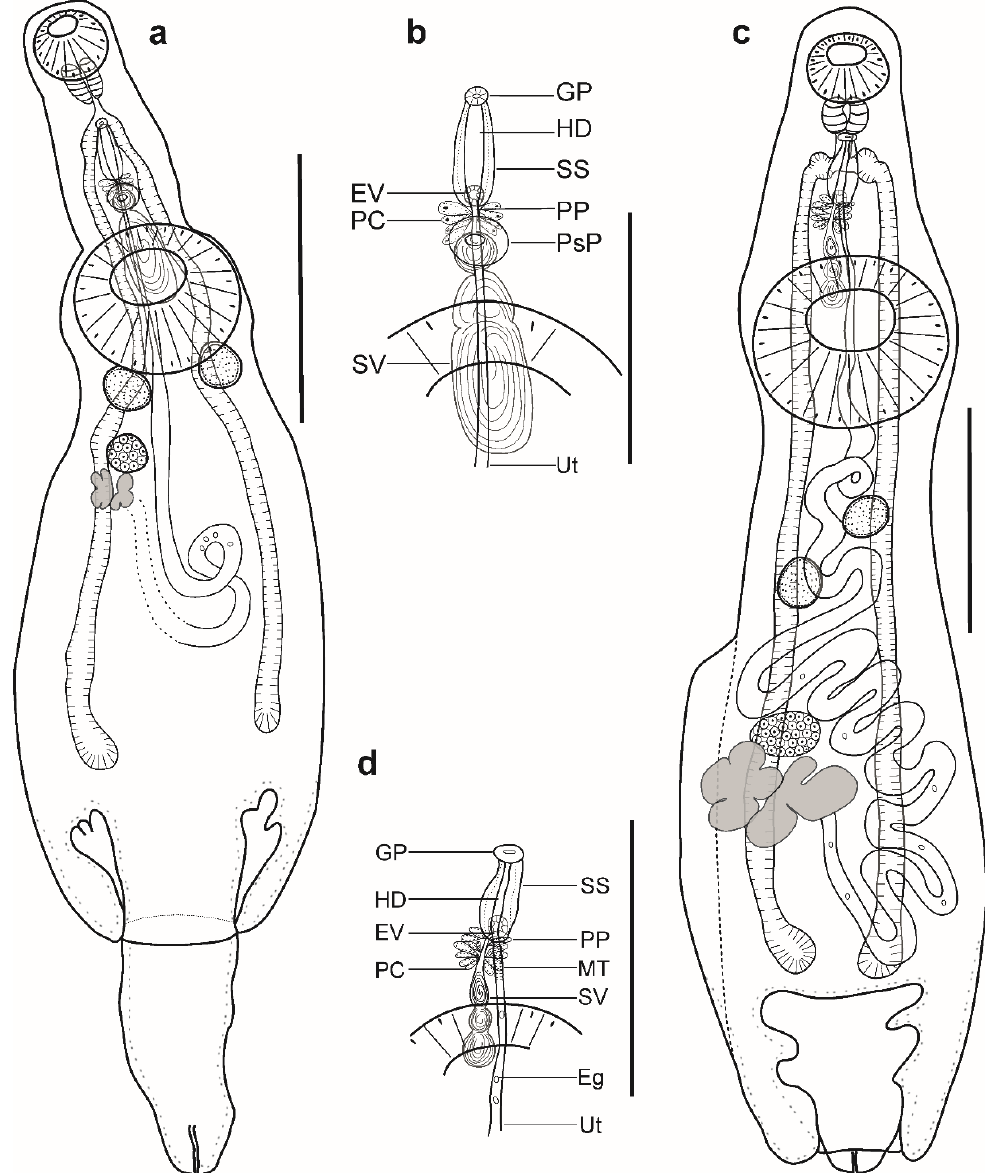
Figure 3. Hemiurid parasites of marine fishes from Brazil. ( a – b ) Adult of Lecithochirium cf. muraenae ex Gymnothorax vicinus : ( a ) complete specimen, ventral view; ( b ) detail of the terminal genitalia, ven- tral view. ( c – d ) Adult of Lecithochirium sp. ex Trichiurus lepturus : ( a) complete specimen, ventral view; ( b) detail of the terminal genitalia, ventral view. Scale bars ( a ): 700 μm, ( b ): 350 μm, ( c – d ): 500 . Abbreviations : Eg, eggs; EV, ejaculatory vesicle; GP, genital pore; HD, hermaphroditic duct; PC, pros- tatic cells; PP, pars prostatica; SS, sinus-sac; SV, seminal vesicle; Ut, uterus.